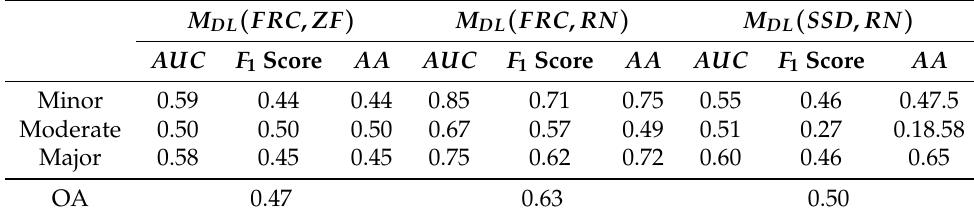
Table 5. Performance of damage-level